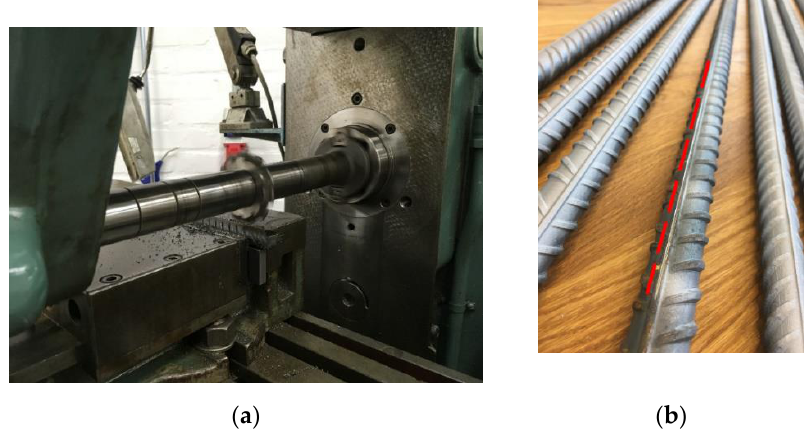
Figure 3. ( a ) Milling of the groove along the rebar’s longitudinal rib and its ( b ) resulting incision marked with a dashed red line.